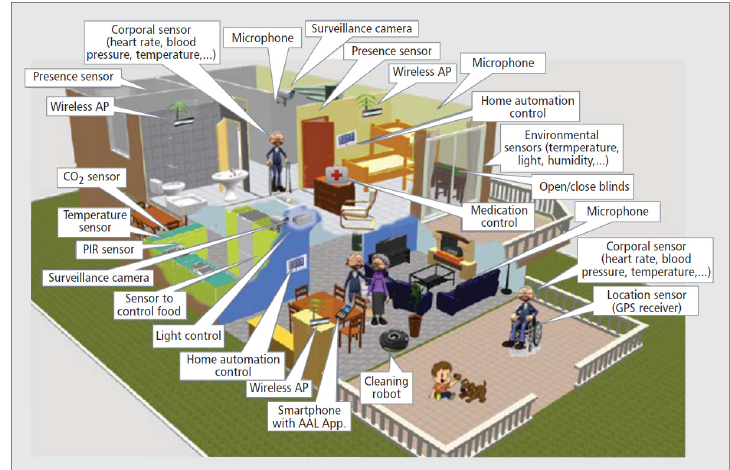
Figure 5. An example of AAL elderly people’s residence or house full of sensors, such as a pres- ence sensor or temperature sensor, and actuators, such as light control, home automation control, medication control, and so on (from